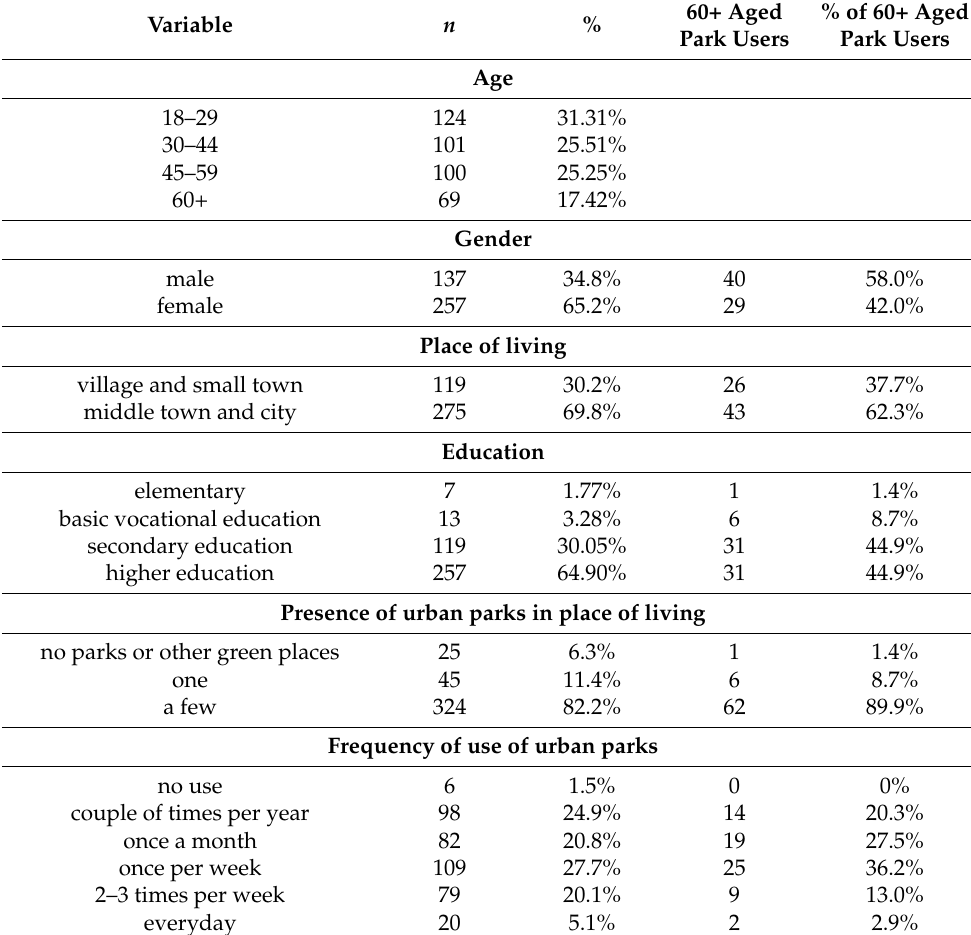
Table 1. Sample characteristics (elaborated by